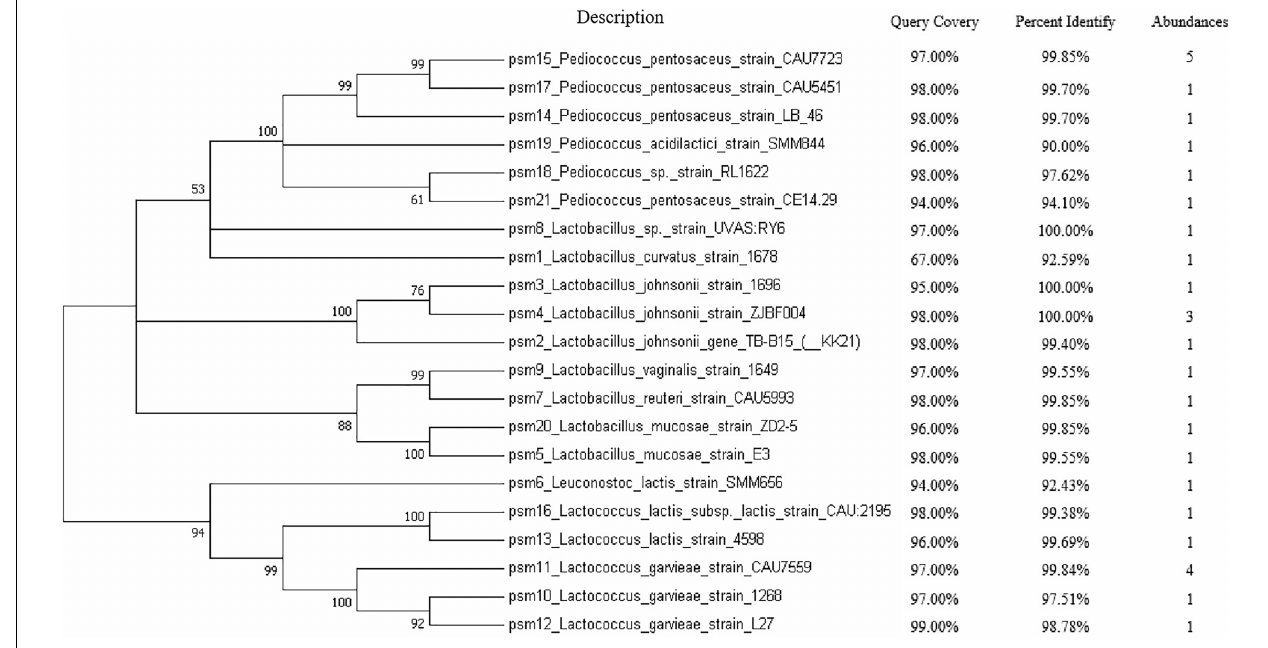
FIGURE 1 | The evolutionary history was inferred using the neighbor-joining method. A bootstrap consensus tree inferred from 1,000 replicates was used to represent the evolutionary history of the taxa analyzed. Branches corresponding to partitions reproduced in less than 50% bootstrap replicates are collapsed. The percentage of replicate trees in which the associated taxa clustered together in the bootstrap test (1,000 replicates) are shown next to the branches whereas the BLAST alignment results are shown. The abundances of the isolated bacterial are shown in the last